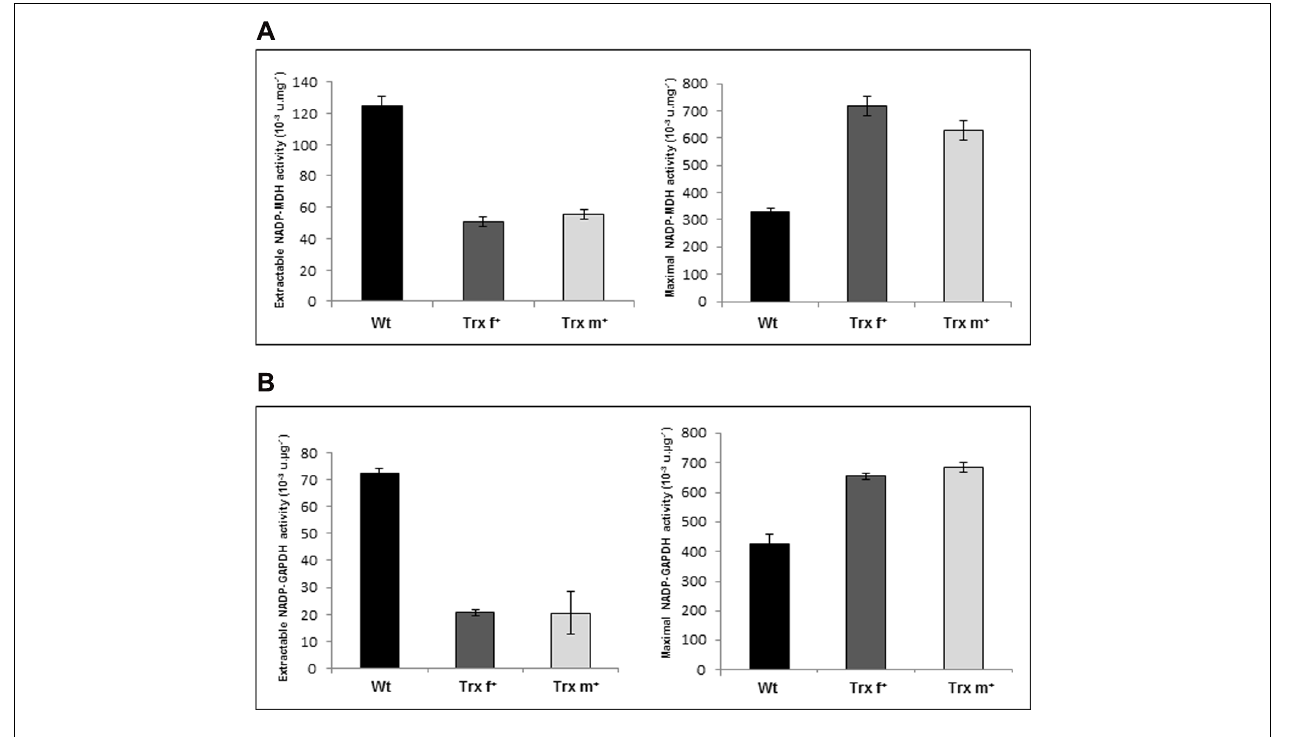
measured after a reducing treatment of protein leaf extracts (25 mM DTT, 20 min at room temperature). Data are mean values ± SD from at least four independent measurements per genotype. Wt, wild-type; Trx f + and Trx m + , plants overexpressing Trx f or Trx m,